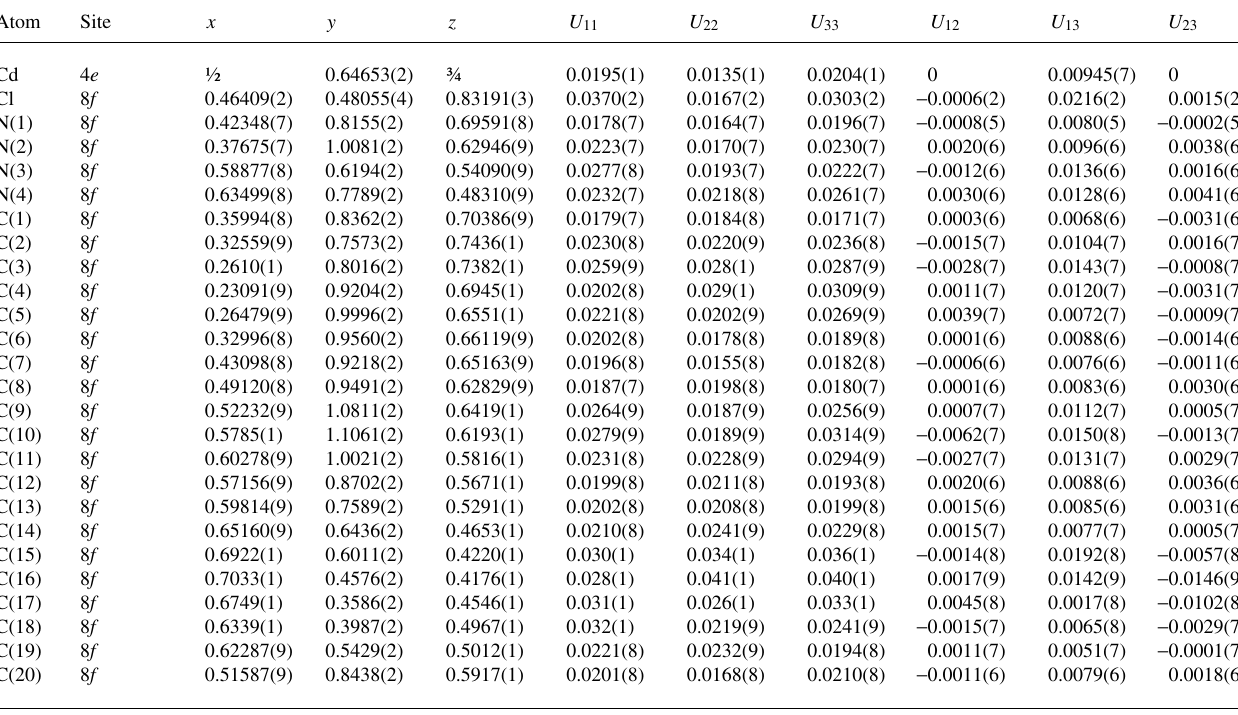
Table 3. Atomic coordinates and displacement parameters (in Å 2 )